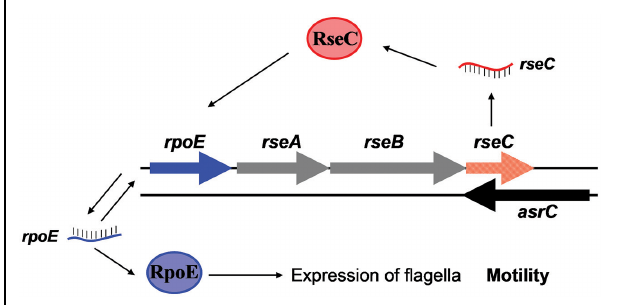
FIGURE 8 | AsrC and its regulatory circuits. AsrC expression increases rseC mRNA and protein levels. RseC positively modulates transcriptional activity of rpoE and increases RpoE ( σ E ) protein. The rpoE gene is positively autoregulated. Enhanced σ E regulatory pathways respond by inducing transcription of genes related to motility. Arrows,